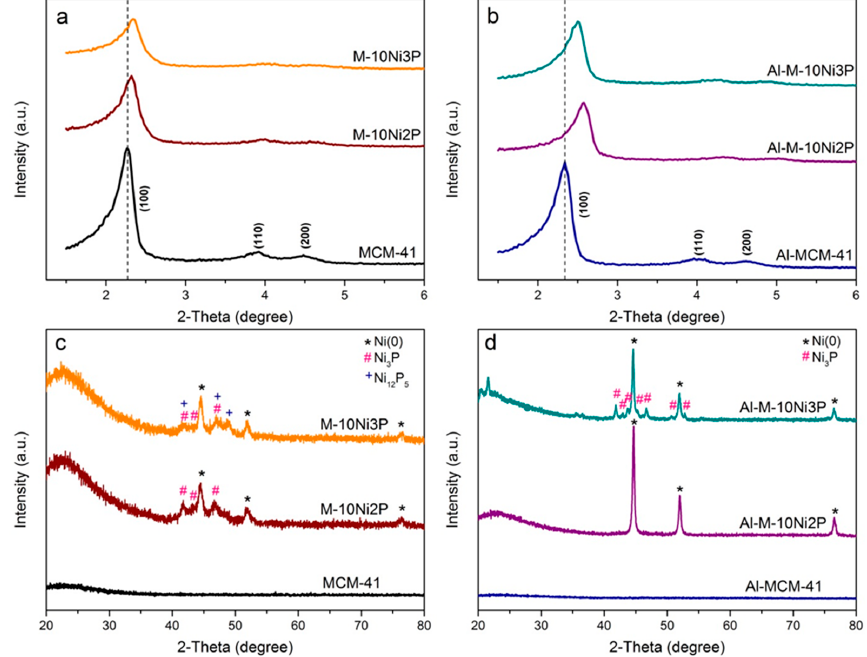
Figure 1. X-ray diffraction patterns of the synthesized materials at low angles ( a–b ) and high angles ( c–d ).